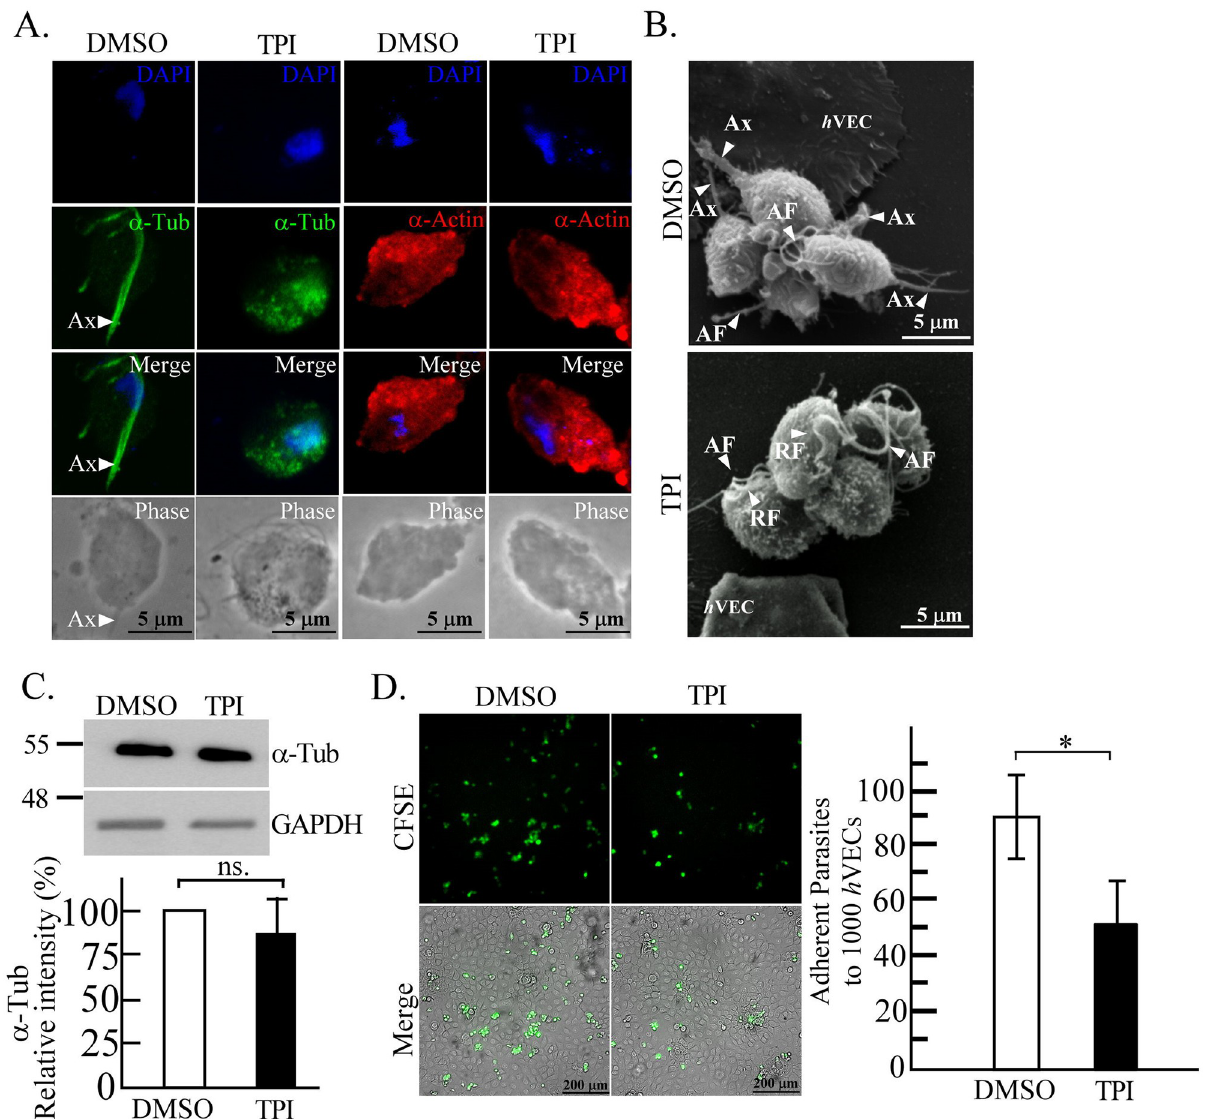
Fig 6. The involvement of the axostyle in the cytoadherence of the TH17 isolate. The trophozoites of TH17 isolate were pretreated with DMSO or TPI. A. the trophozoites cultured on a glass slide were examined by IFA using anti- α -tubulin or anti- α -actin antibodies. B. Axostyles in the trophozoites co-cultured with h VECs were observed by SEM. The arrowheads indicate axostyle (Ax); anterior flagellum (AF); recurrent flagellum (RF). C. Protein lysates from treated TH17 trophozoites were subjected to western blotting using anti- α -tubulin ( α -Tub) or anti-GAPDH antibodies. D. CFSE- prelabelled trophozoites were co-cultured with h VECs (moi 1:3) for 30 min and the number of trophozoites bound per 1,000 h VECs was calculated as shown in the bar graph (mean ± SD). All assays were repeated three times. Significant differences were statistically analyzed by the Student’s t-tests with P < 0.01( �� ), P < 0.05 ( � ), and ns, not significant.